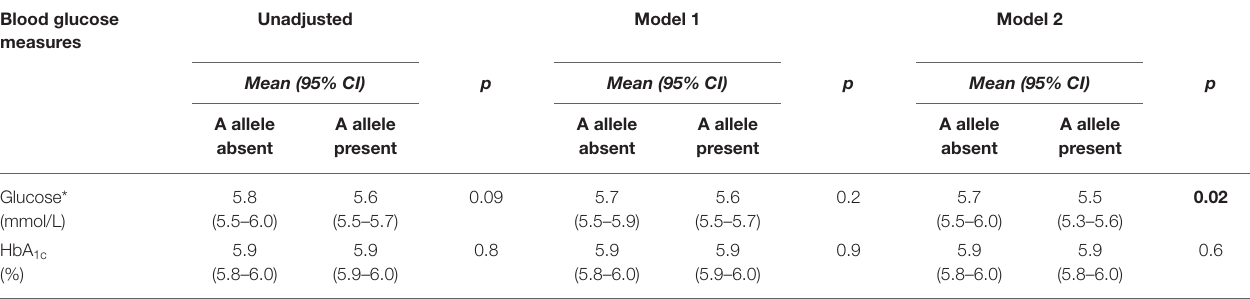
A allele A allele absent present